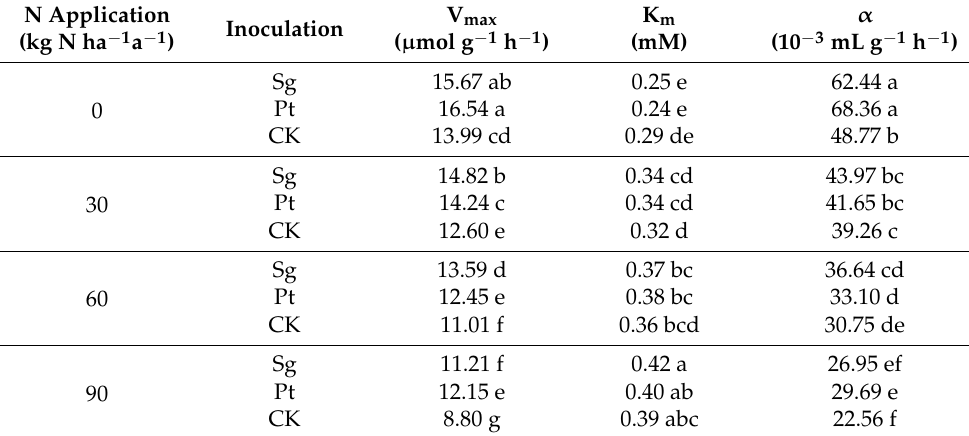
Table 5. The kinetic parameters of NO 3 − absorption by roots of Pinus massoniana seedlings after nitrogen application and inoculation with ectomycorrhizal fungi.